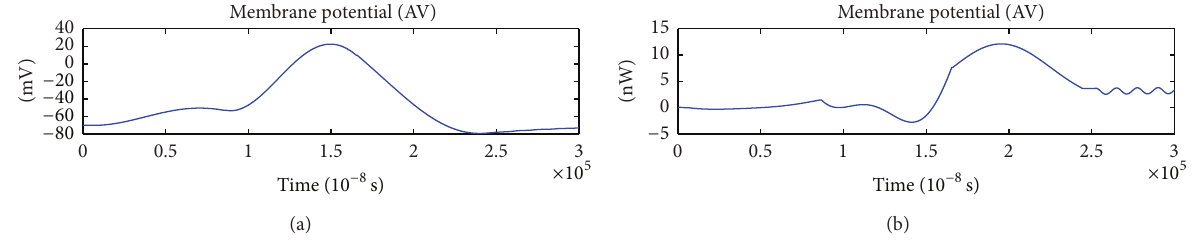
Figure 2: Action potential and its corresponding energy function. 𝑟 0𝑚 = 0.0001 Ω , 𝑟 1𝑚 = 0.1 Ω , 𝑟 2𝑚 = 1000 Ω , 𝑟 3𝑚 = 0.1 Ω , 𝑟 𝑚 = 1000 Ω , = 1 𝜇 F, 𝐿 = 50 𝜇 H, and 𝑖 = 70.7 𝜇 A. 𝐶 𝑚 𝑚 0𝑚